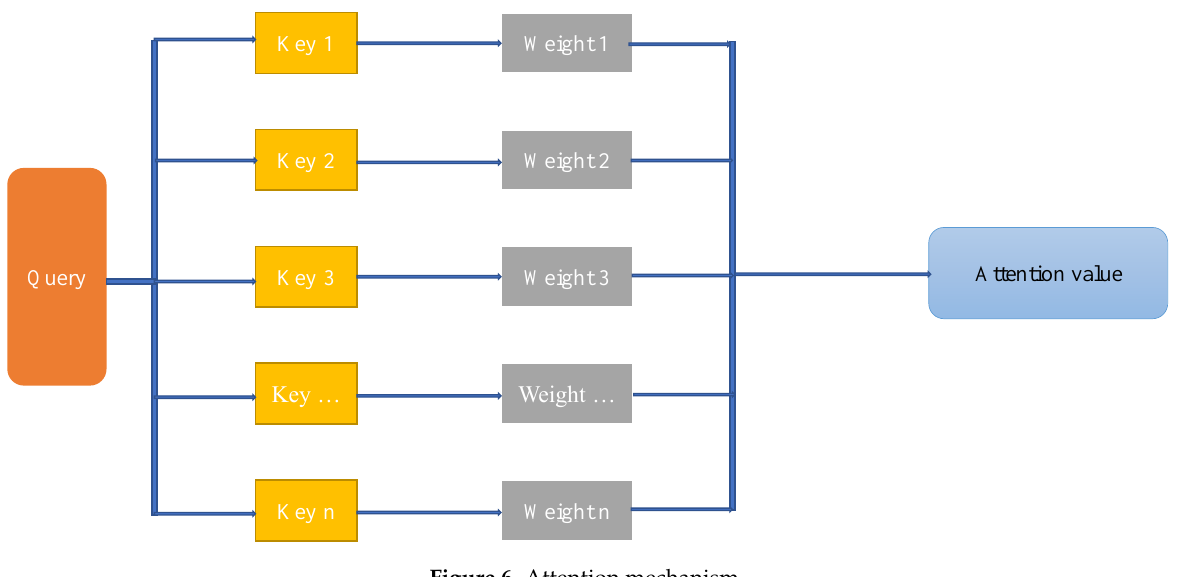
Figure 6. Attention mechanism.